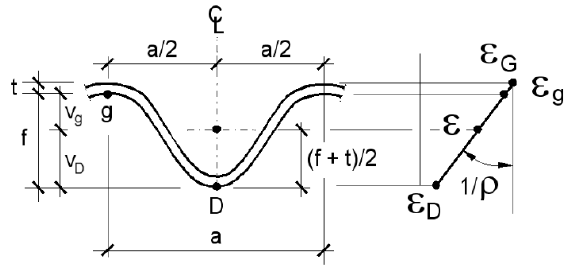
Figure 2: Cross section of the circumferential band of the